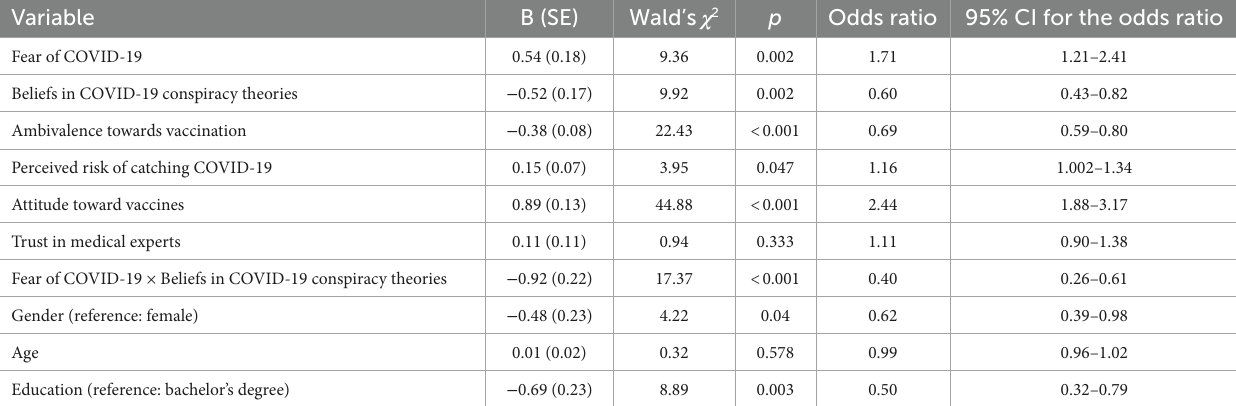
TABLE 3 Summary of logistic regression analysis for variables predicting intention to take the COVID-19 vaccine. Variable